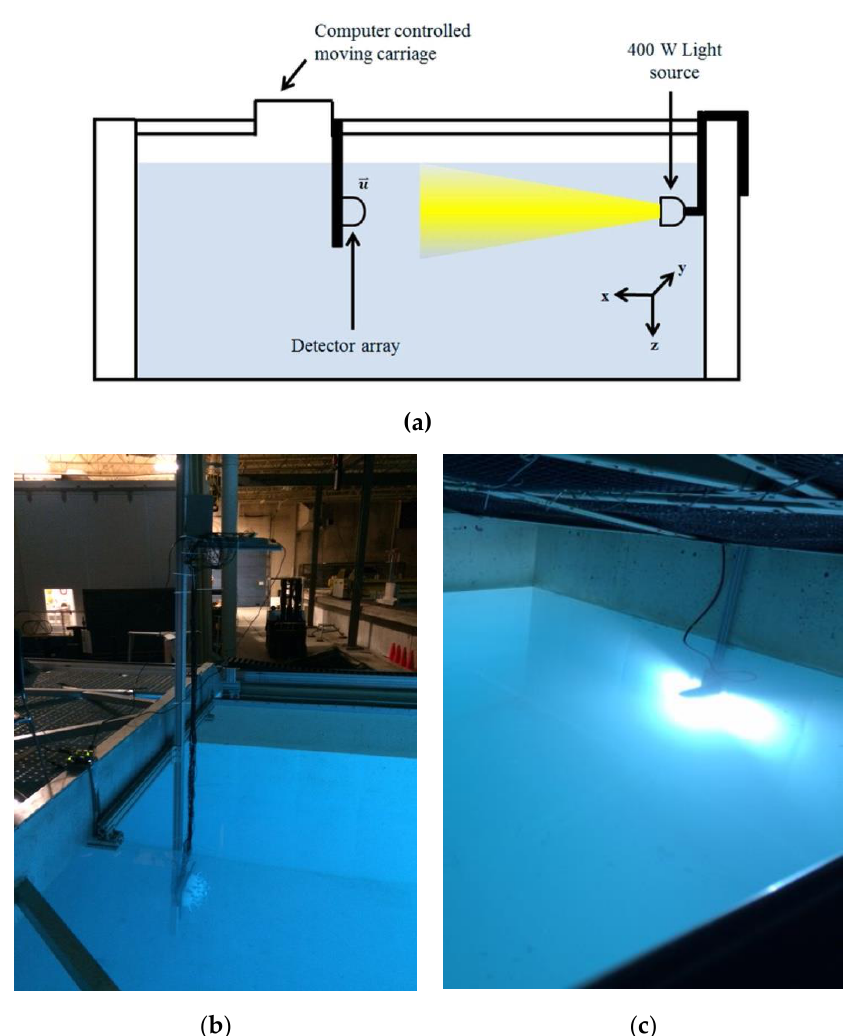
Figure 9. ( a ) Schematic diagram of the experimental setup in the wave and tow tank; ( b ) image of the detector array submerged into the water on the moving carriage platform; and ( c ) image of the light source mounted on the wall of the tank.